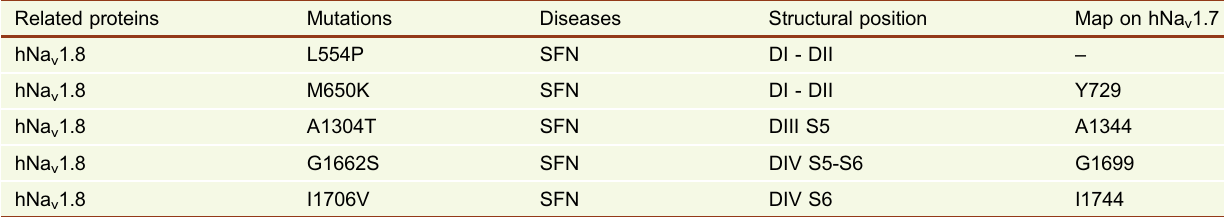
SFN: Small fi ber neuropathy.